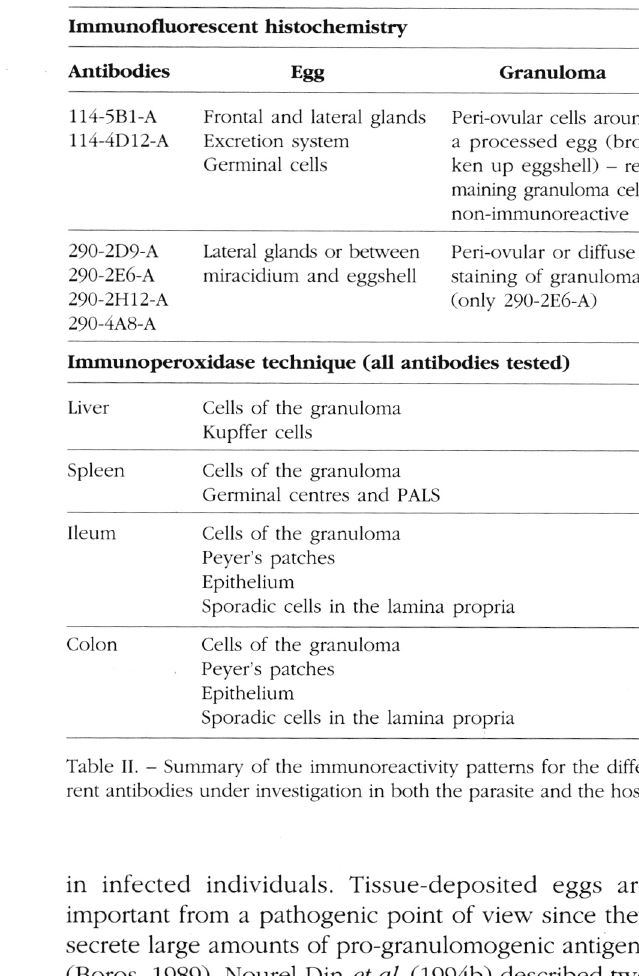
in infected individuals. Tissue-deposited eggs are important from a pathogenic point of view since they secrete large amounts of pro-granulomogenic antigens (Boros, 1989). Nourel Din et al. (1994b) described two antibodies (114-5B1-A and 114-4D12-A) that strongly reacted with repetitive carbohydrate epitopes on solu­ ble S. mansoni egg antigens. The tissue distribution of the antigens recognised by these antibodies was next established in both the parasite (5. mansoni ) (Bogers et al., 1994, 1995a) and the host (Bogers et al., 1995b). With these antibodies we observed similarities in the reaction pattern in the parasite S. haem atobium